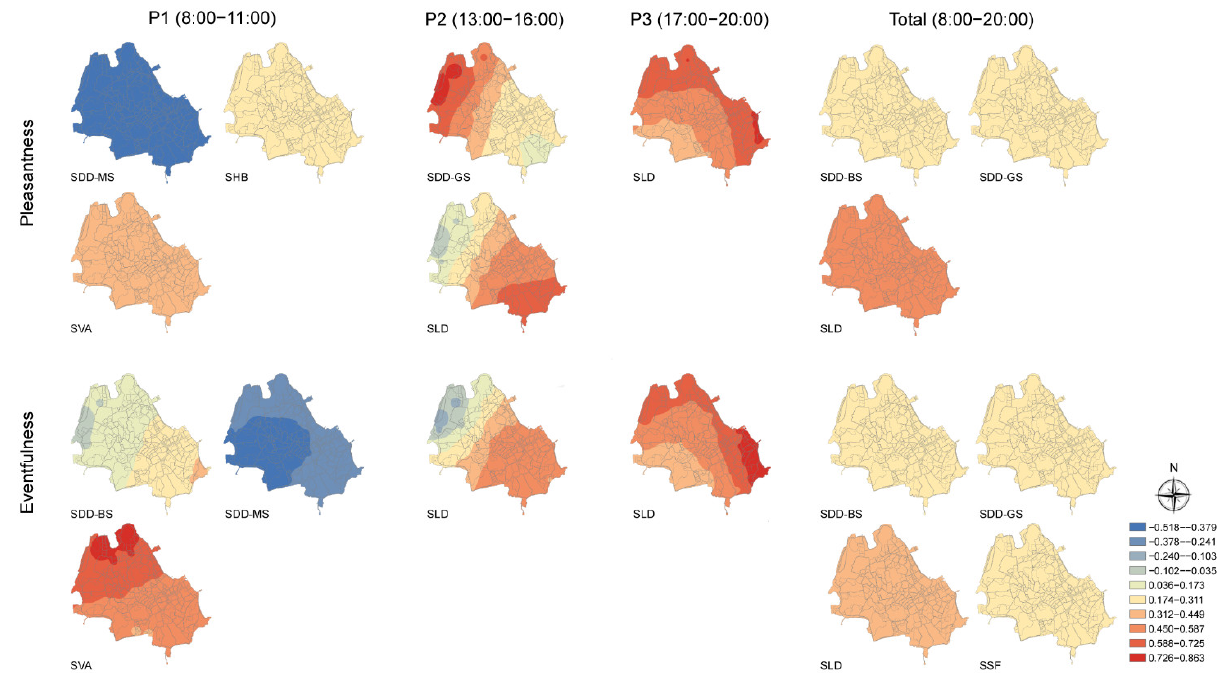
Figure 8. Spatial distribution of local coefficients of significant variables in the three and total sampling period.